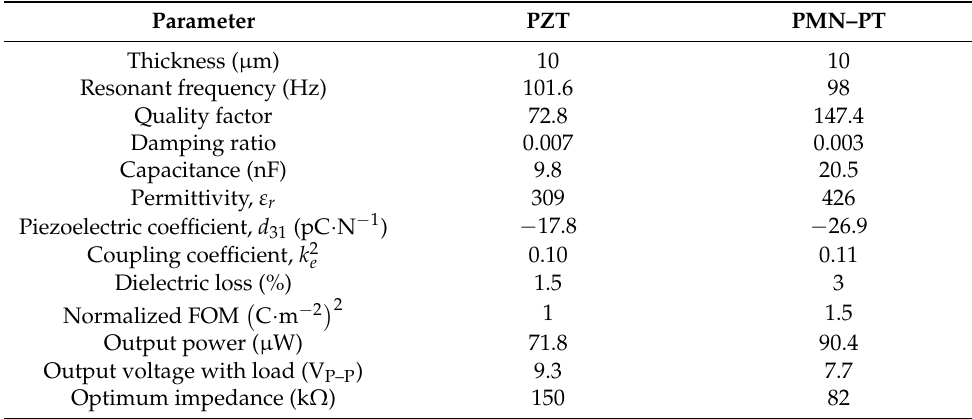
Table 4. Comparison of the parameters of the PZT and PMN–PT materials.